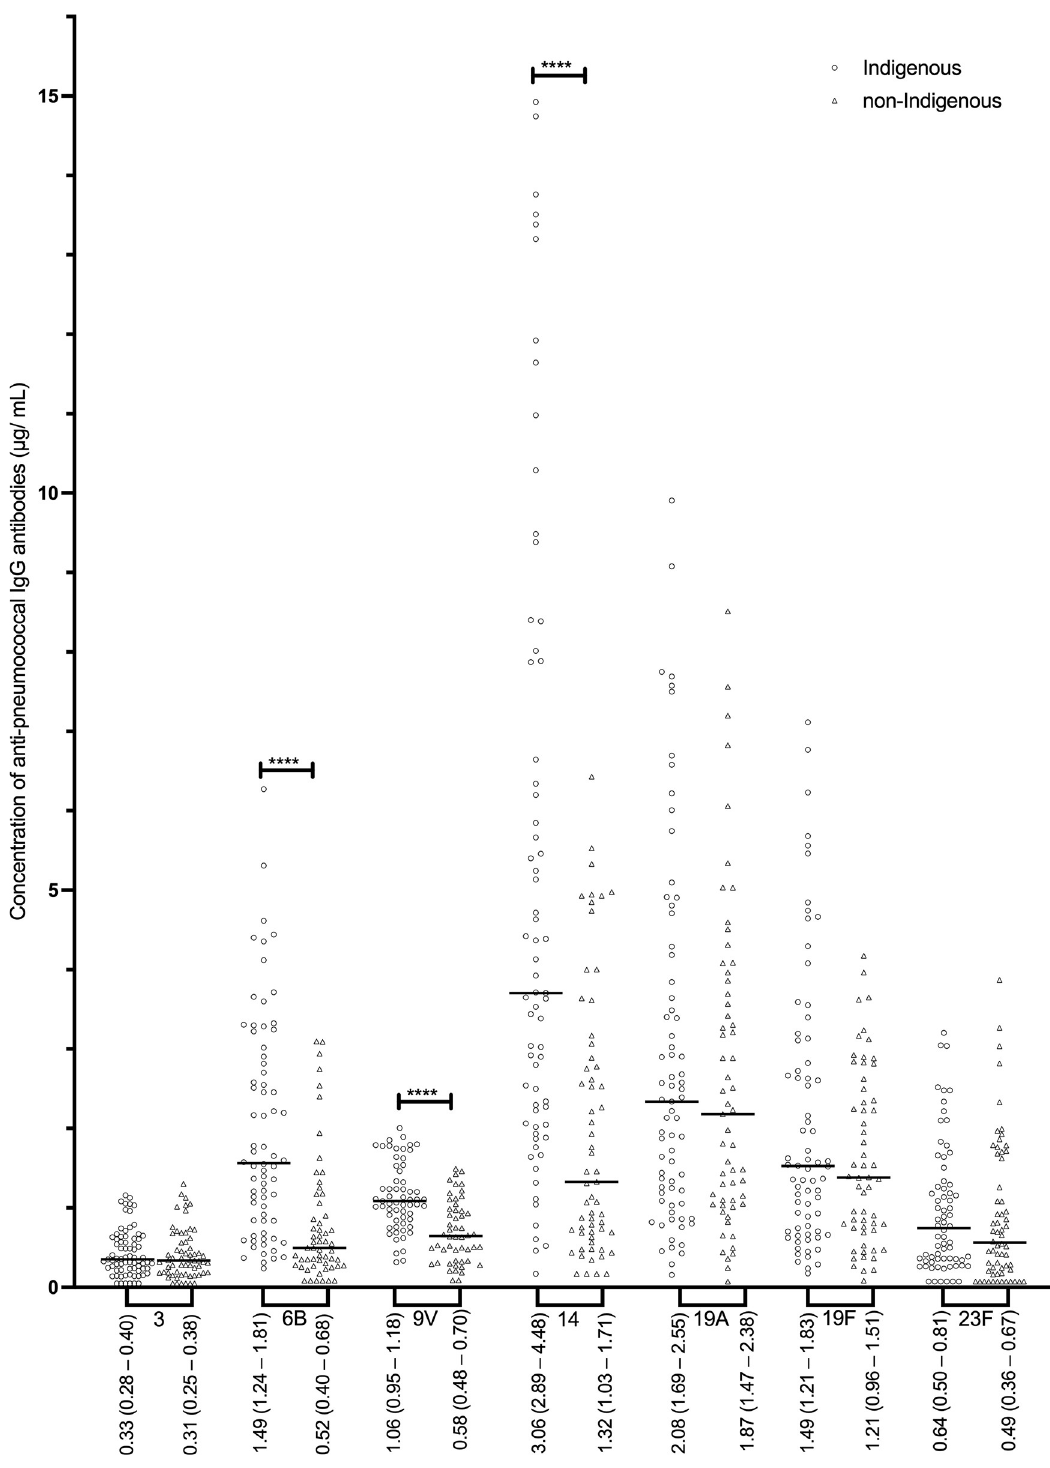
Fig 1. Concentrations of serotype-specific pneumococcal IgG antibodies for Indigenous (n = 77) and non-Indigenous groups (n = 64). Geometric mean antibody concentrations (GMC) are displayed ( μ g/ mL) and the 95% confidence intervals of the GMC. Statistical significance was determined using a Mann-Whitney U test for all serotypes. ���� p < 0.0001.